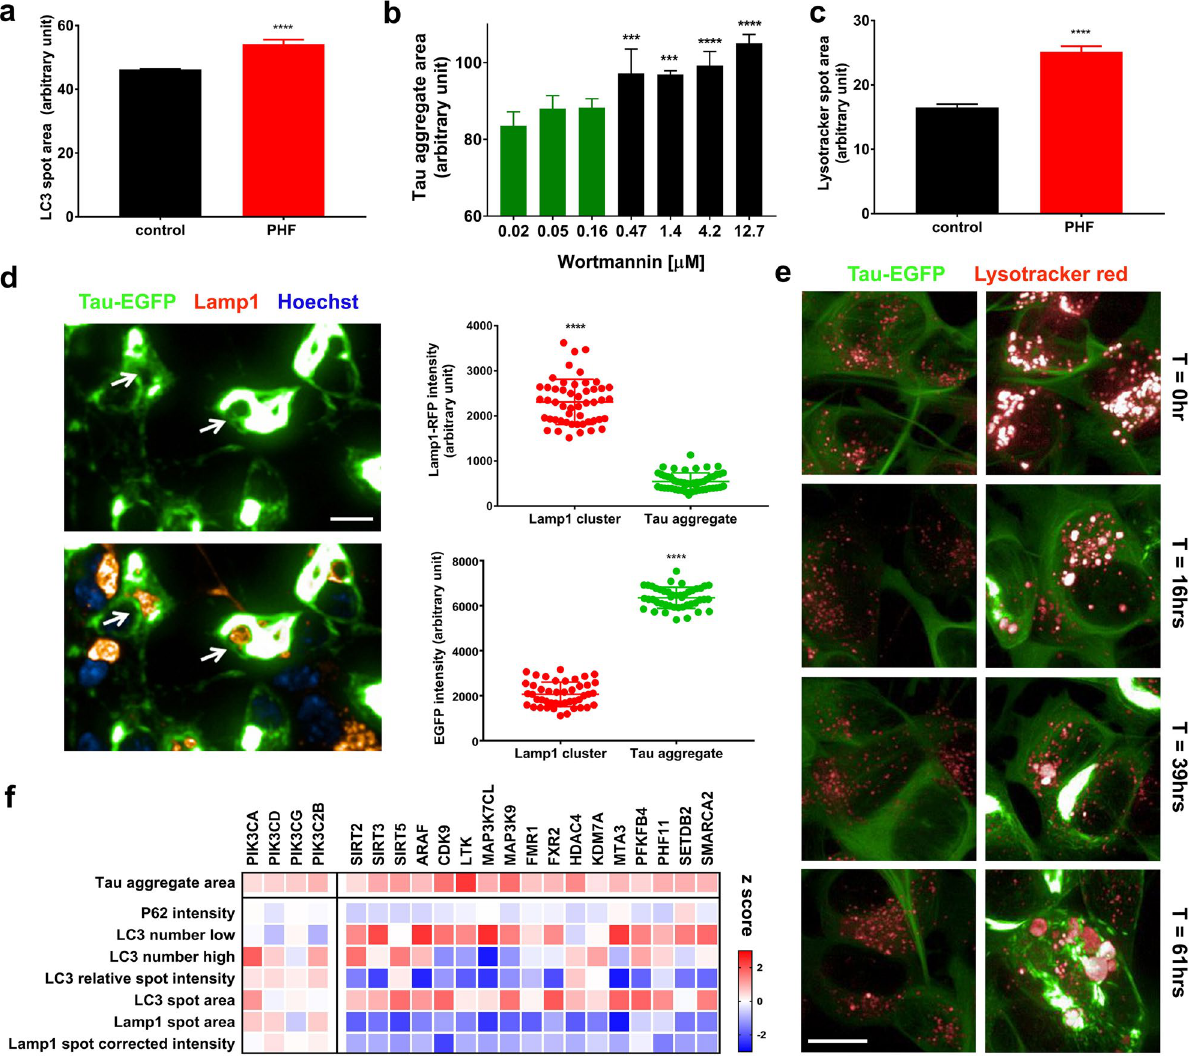
Figure 4. Interaction of tau aggregation with autophagosome and lysosome dynamics. ( a ) PHF-treated cells display significantly enlarged LC3 positive autophagosome, n = 4, two-tailed unpaired t-test. ( b ) pan- PI3K autophagy inhibitor wortmannin concentration dependently increases tau aggregate spot area, n = 4, One-way ANOVA with Tukey’s multiple comparisons, F (6, 20) = 19.74, p < 0.0001. ( c ) PHF-treated cells significantly increase lysosome size marked by lysotracker red, n = 5, two-tailed unpaired t-test. ( d ) LAMP1- positive lysosome clusters and tau-EGFP aggregates are mutually exclusive, two-tailed unpaired t-test. ( e ) Live imaging of lysosome coalescence via lysotracker red during tau aggregation process, scale bar = 10 μM. ( f ) Tau aggregation, autophagy and lysosome profiles of examples genes similar to wortmannin and SIRT2 . Error bars indicate standard deviation. *** p -value < 0.001, **** p -value <